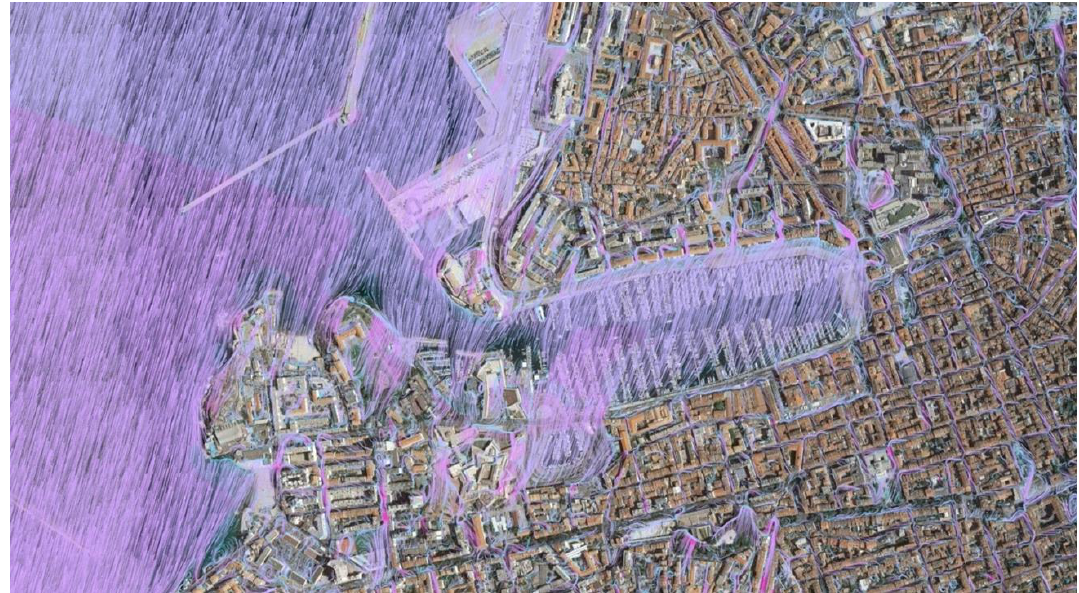
Figure 6. View of the flow streamlines computed in the Vieux Port area in Marseille. North is at the top.